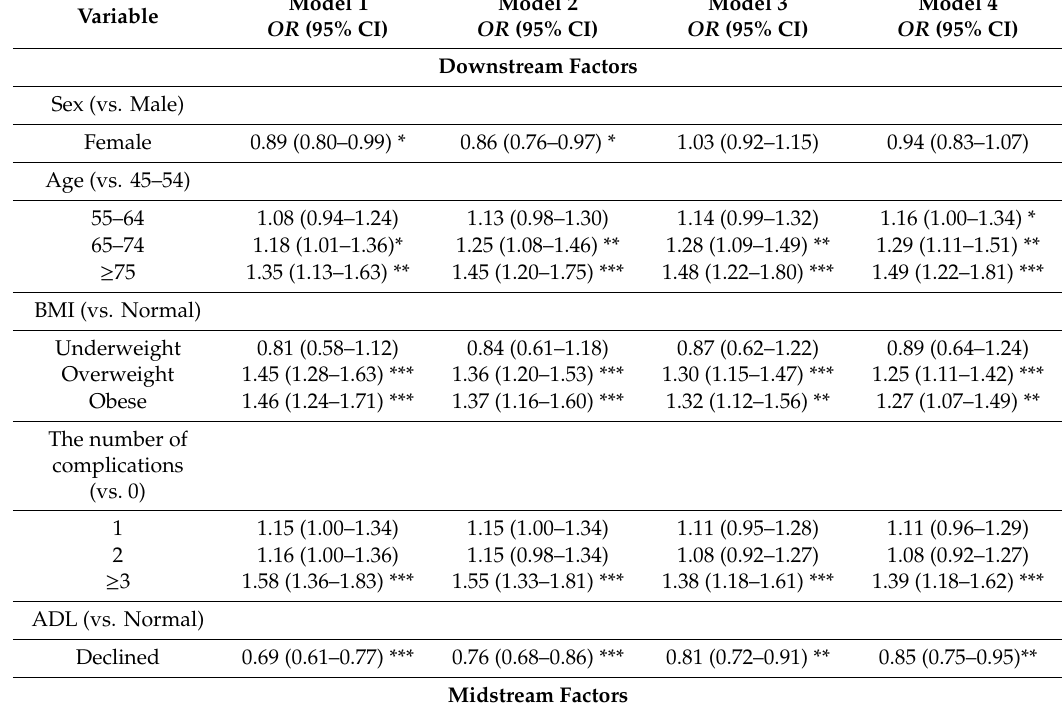
Table 3. Multi-factor logistic regression models for blood pressure monitoring compliance